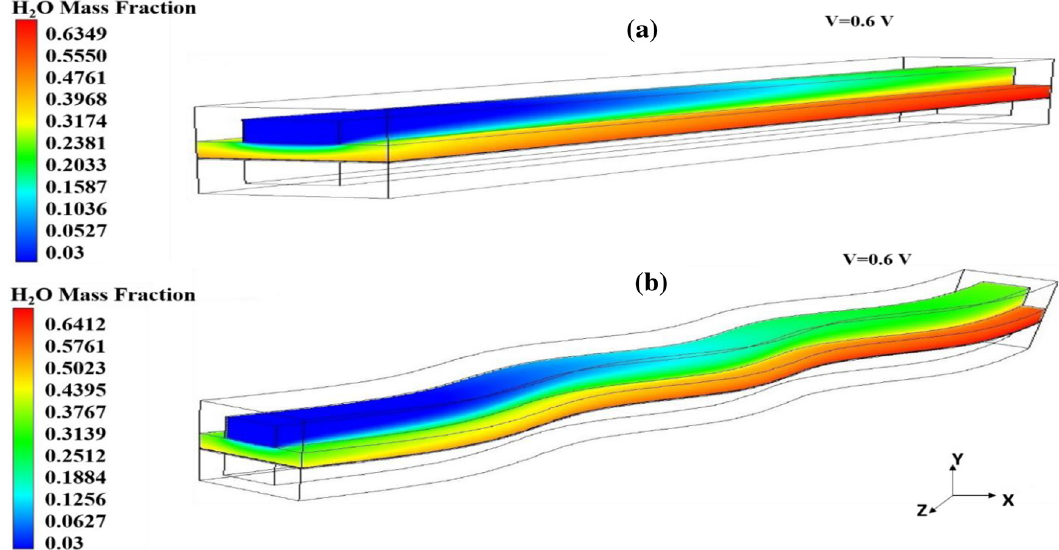
Fig. 5. Water mass fraction distribution contour along the anode channel for two different fl ow designs at